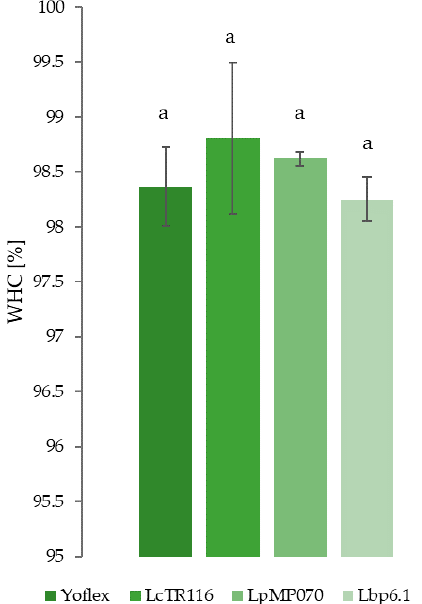
Figure 5. Water holding capacity (WHC) as measured by centrifugation method. Error bars represent standard deviations. Values with the same superscript letter are not significantly different ( p > 0.05).